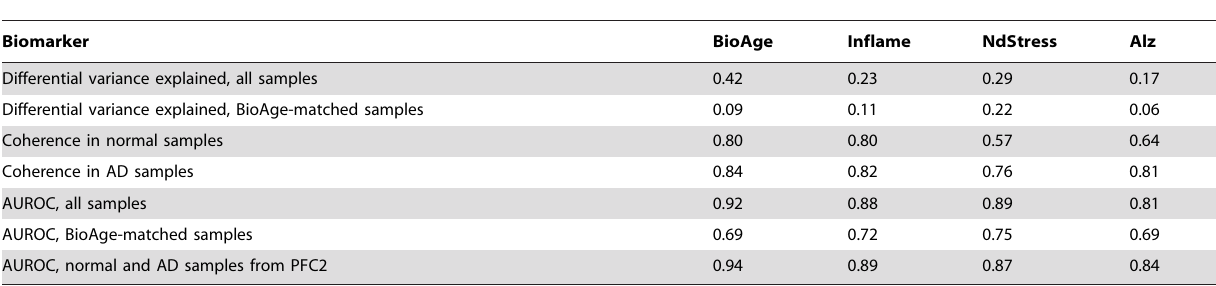
Table 1. Biomarker